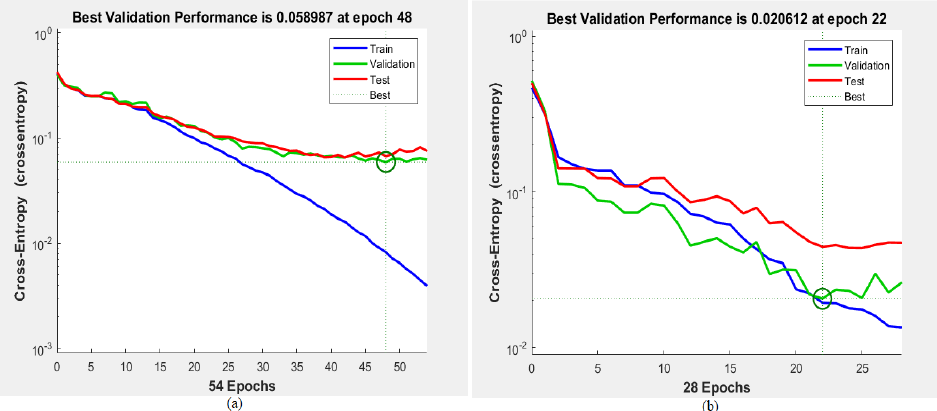
Figure 12. Performance plot of the training of the ANN algorithm considering the datasets used. ( a ) The ISIC 2018 dataset. ( b ) The PH2 dataset.